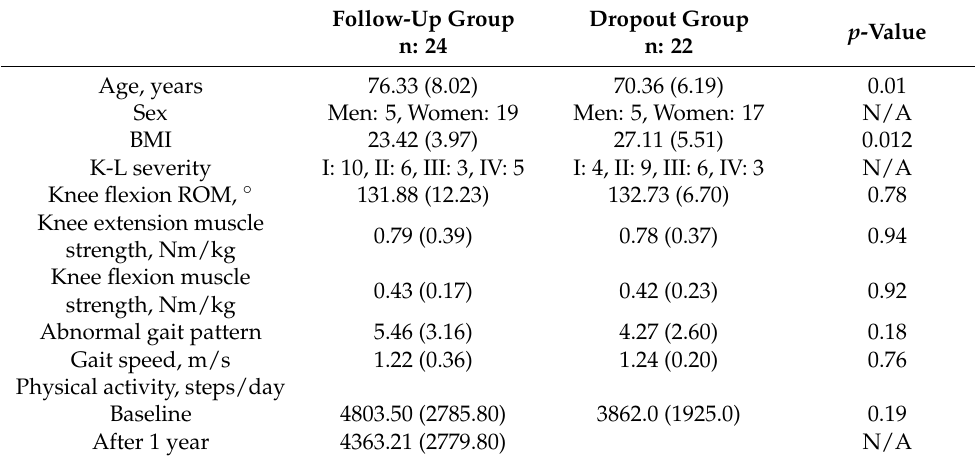
Table 1. Subject descriptive statistics.